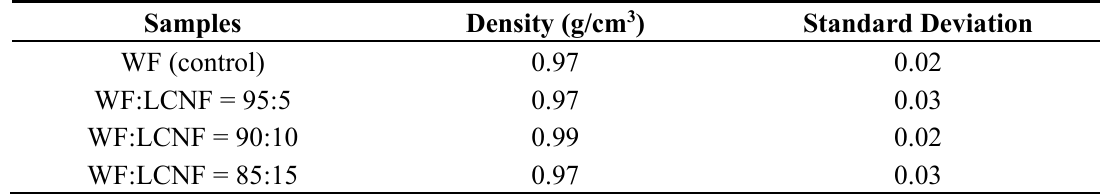
Table 4. Board densities are given as a function of lingo-cellulose nanofibers (LCNF)